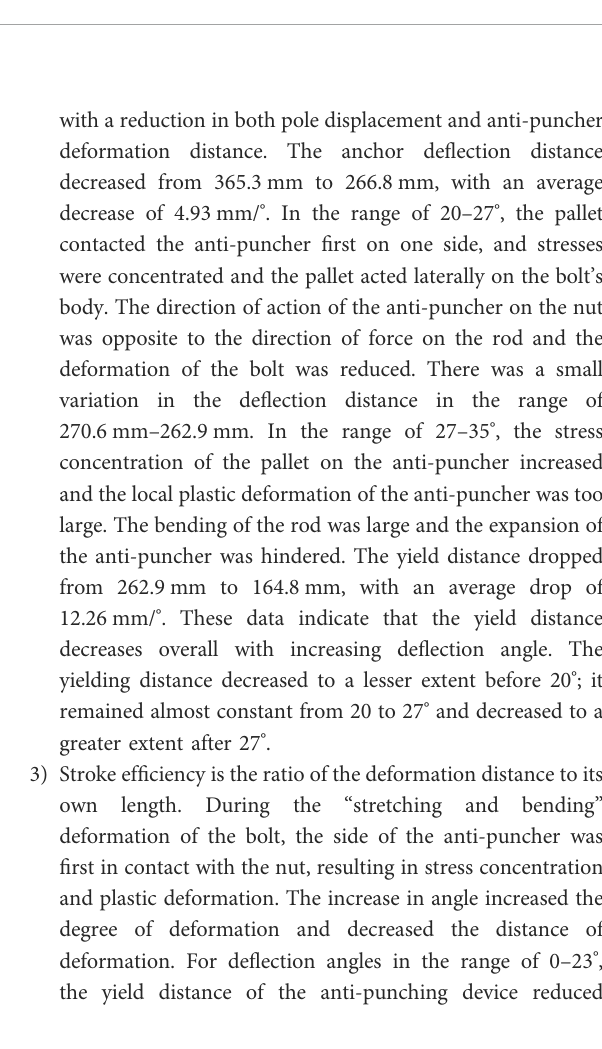
FIGURE 6 Force-displacementcurvesforboltwithdifferentde fl ectionangles. (A) 0,3,5,and7 ° , (B) 10,13,15,and17 ° , (C) 20,23,25,and27 ° ,and (D) 30,33, and 35 ° .